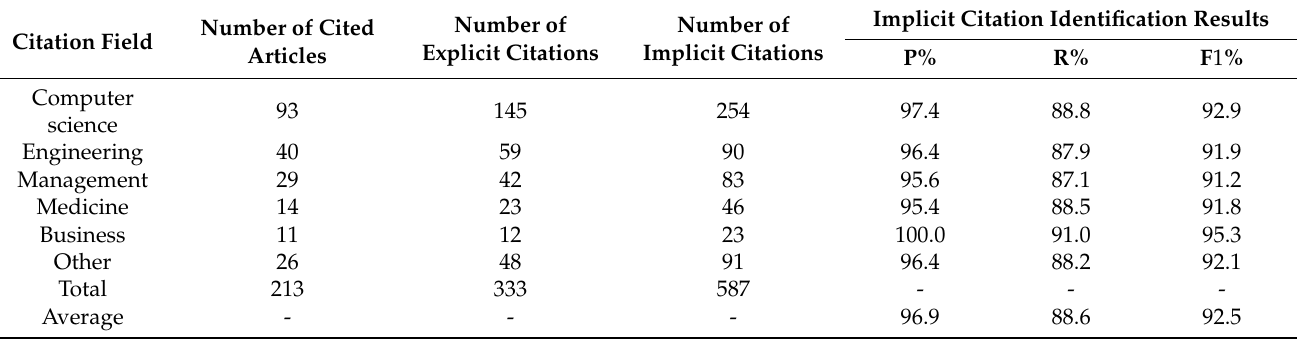
Table 8. Implicit citation sentence detection results of highly cited papers for LDA topic